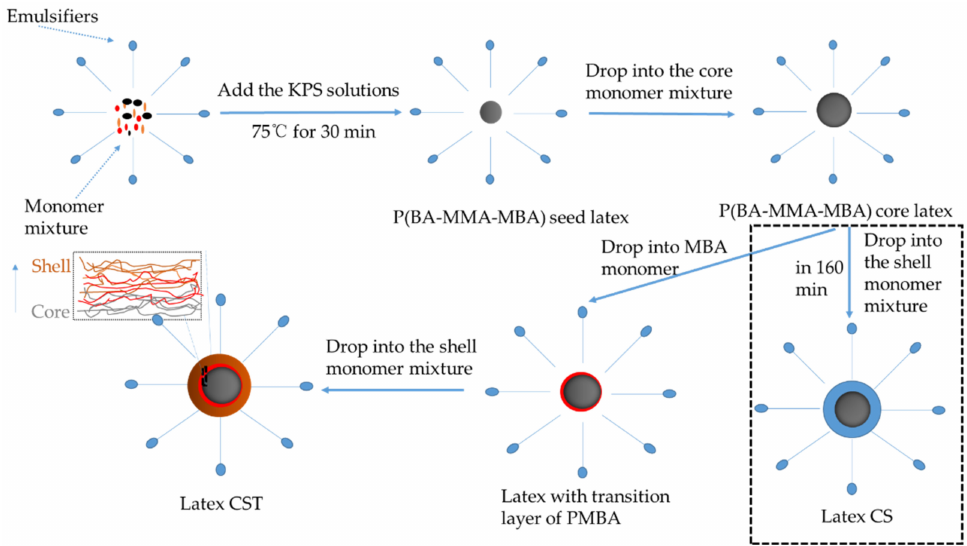
Scheme 1. Synthesis process of experimental